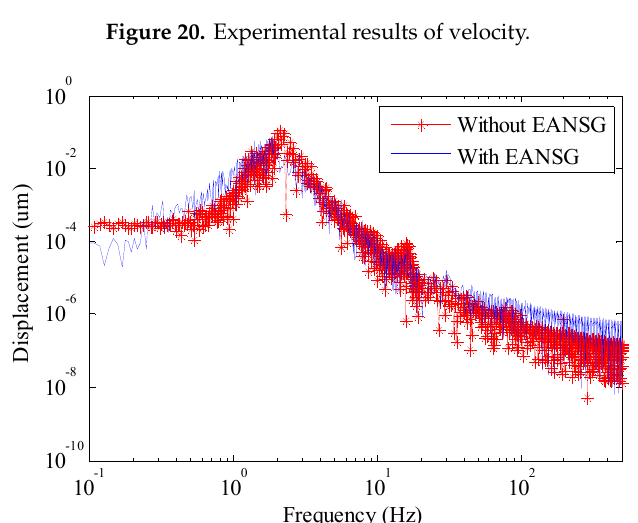
Figure 21. Spectrum analysis of displacement.